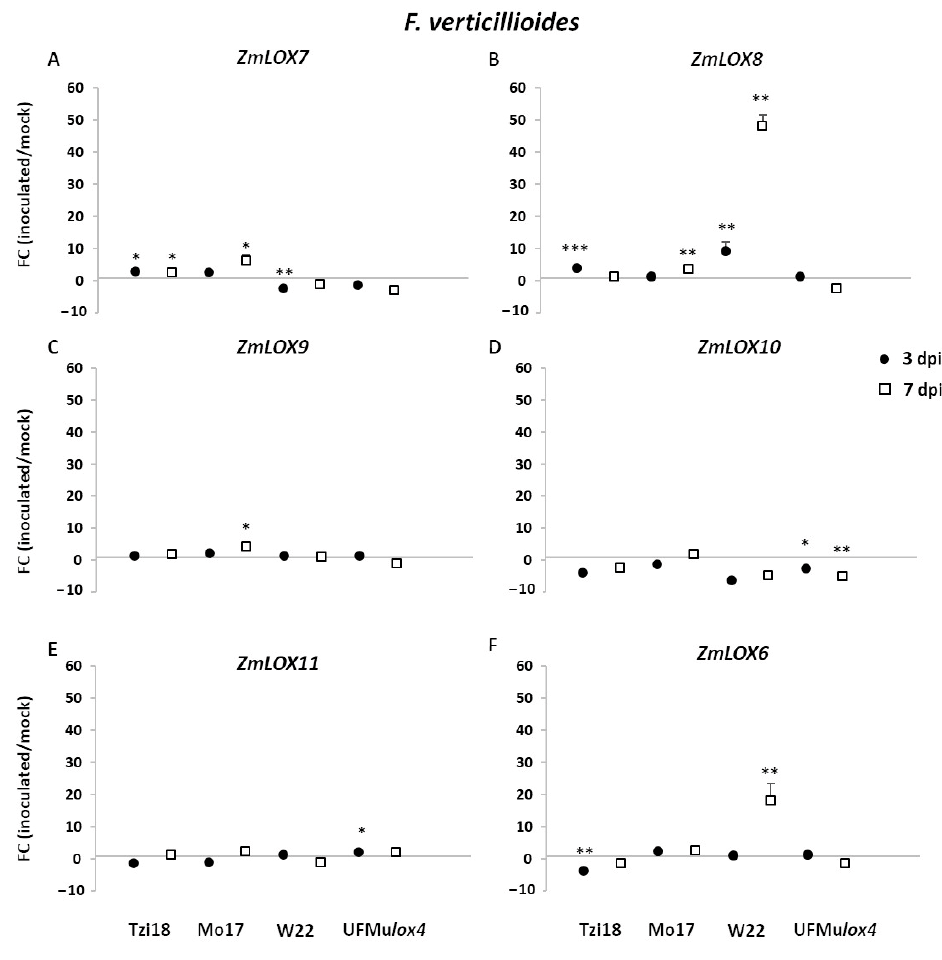
Figure 5. RT-qPCR analysis of maize 13-LOX genes upon F. verticillioides inoculation. Fold change (FC) of expression between inoculated and mock kernels of Tzi18, Mo17, W22, and UFMu lox4 lines at 3 (circle) and 7 (square) dpi with F. verticillioides . ( A ) ZmLOX7 , ( B ) ZmLOX8 , ( C ) ZmLOX9 , ( D ) ZmLOX10 , ( E ) ZmLOX11, and ( F ) ZmLOX6 . Vertical bars indicate the standard error. Asterisk denotes significant upregulation/downregulation with 2-fold or higher FC using Welch’s t -test (* p ≤ 0.05; ** p ≤ 0.01; *** p ≤ 0.001).